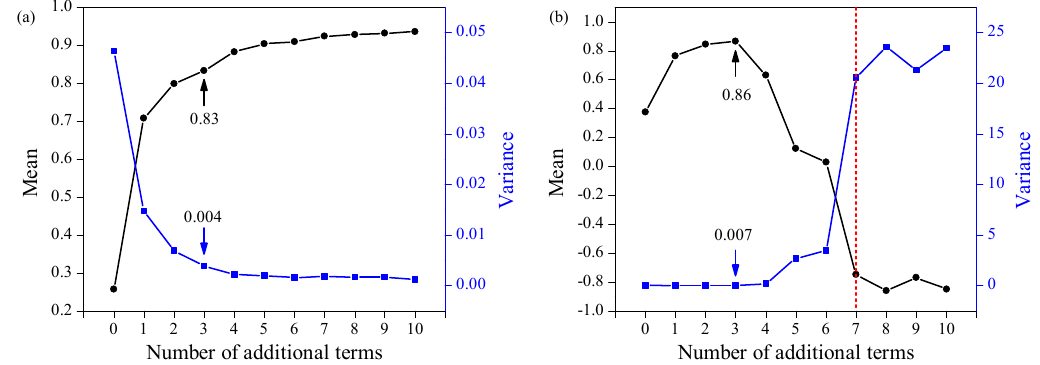
Figure 8. Mean and variance of adjusted R-square during ( a ) the calibration period and ( b ) the validation period.